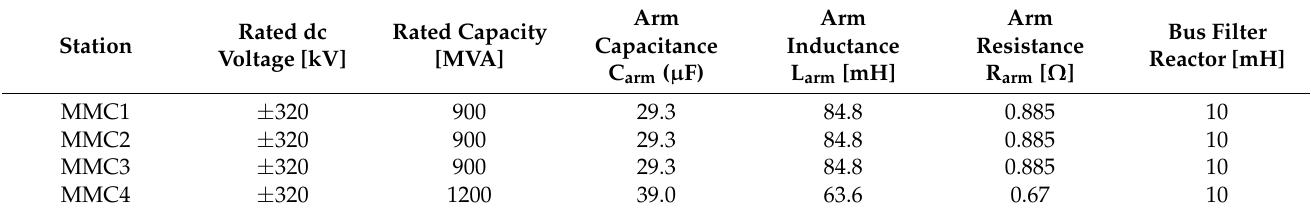
Table 3. AC/dc System parameters .